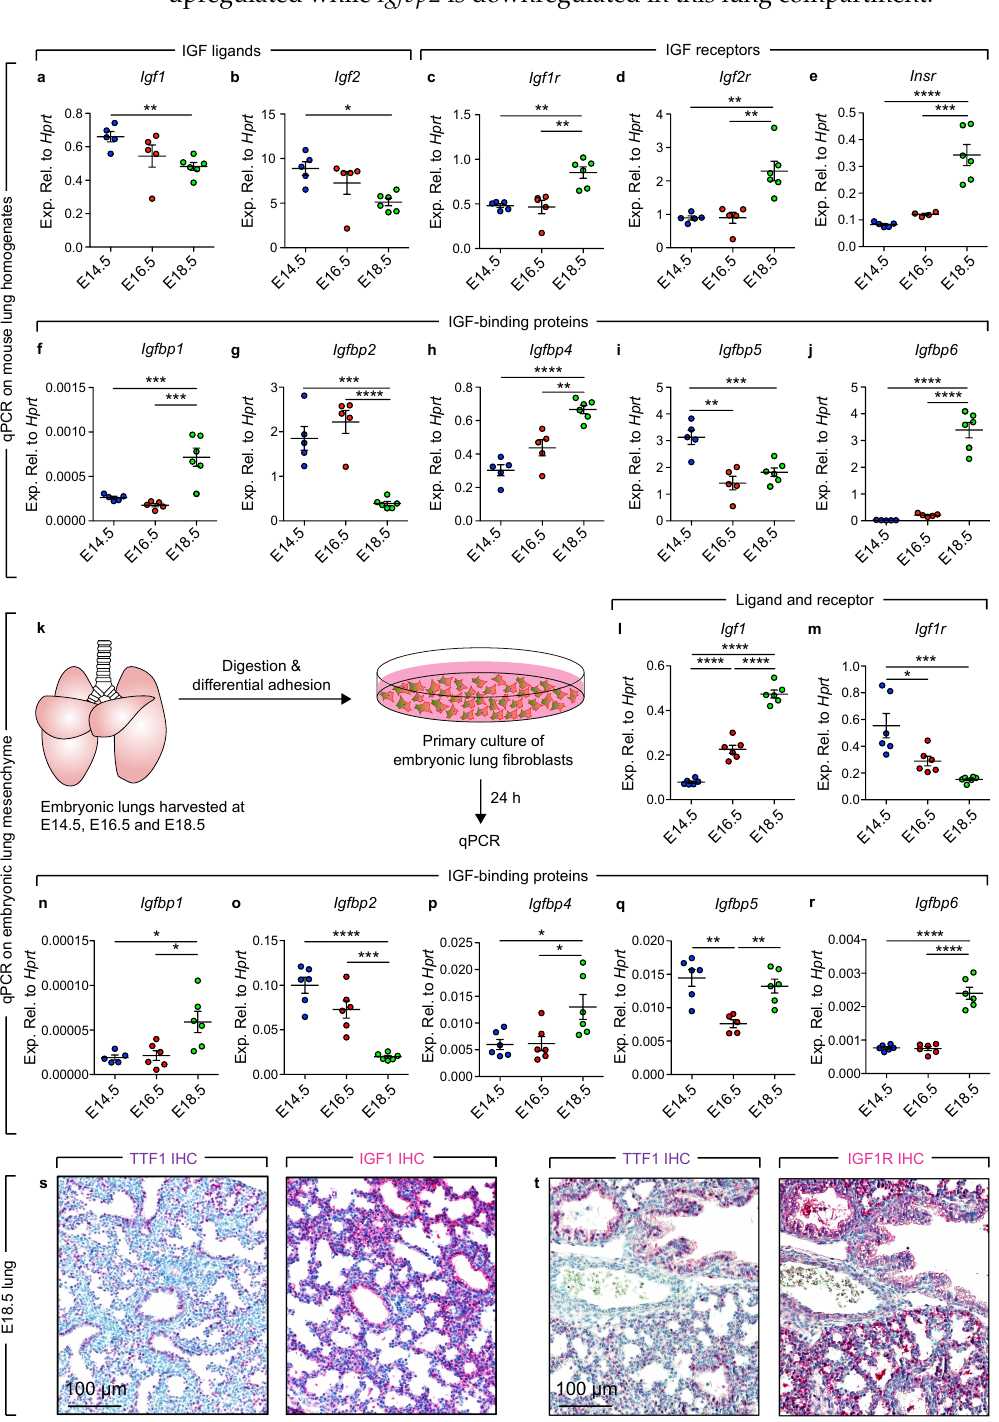
is downregulated in the lung mesenchyme during last gestation. Moreover, Igfbp1/4/6 are upregulated while Igfbp2 is downregulated in this lung compartment.